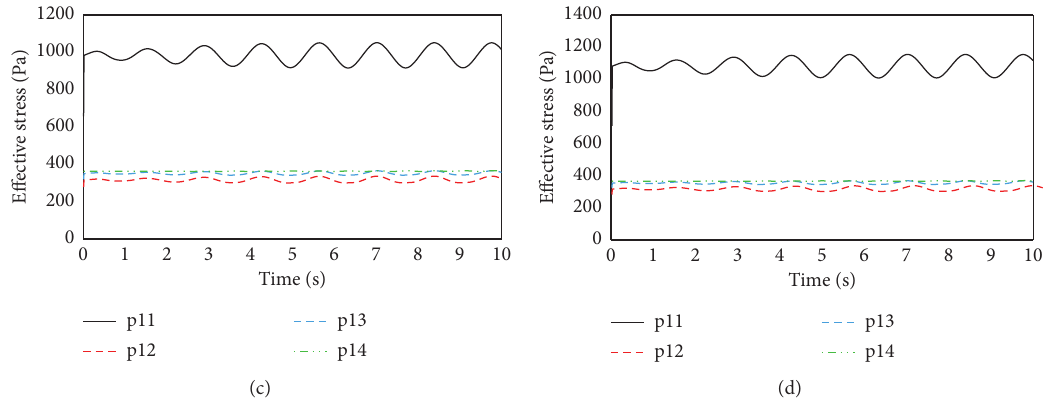
Figure 23: Comparison of effective stress in horizontal direction of different radian baffles: (a) r � 0.132m, (b) r � 0.136m, (c) r � 0.140m, and (d) r �